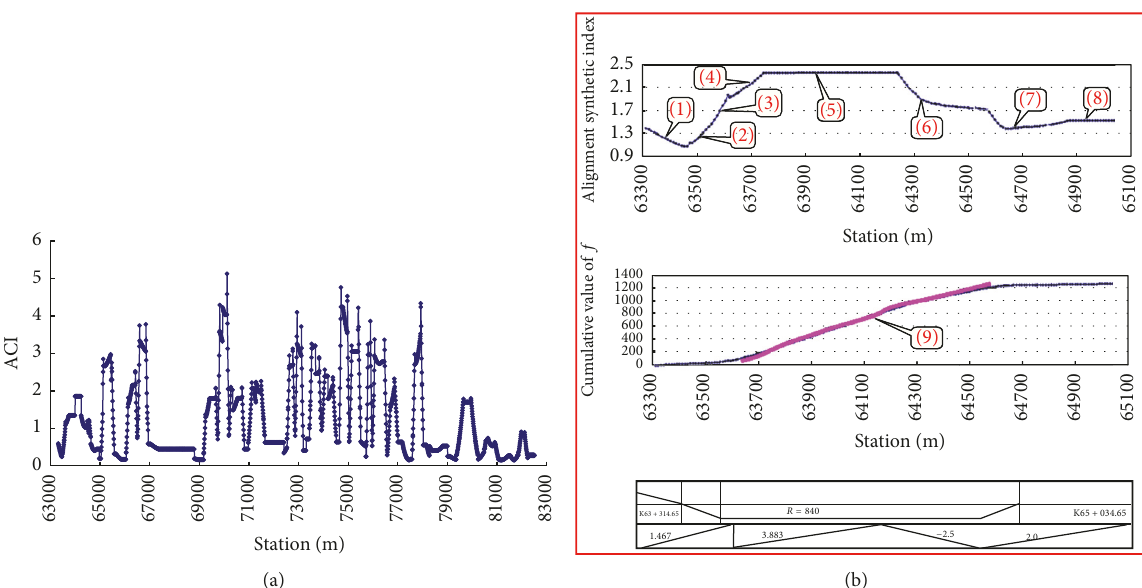
Figure 3: Alignment comprehensive index variations. (a) ACI at each point. (b) Distribution of cumulated alignment comprehensive index.